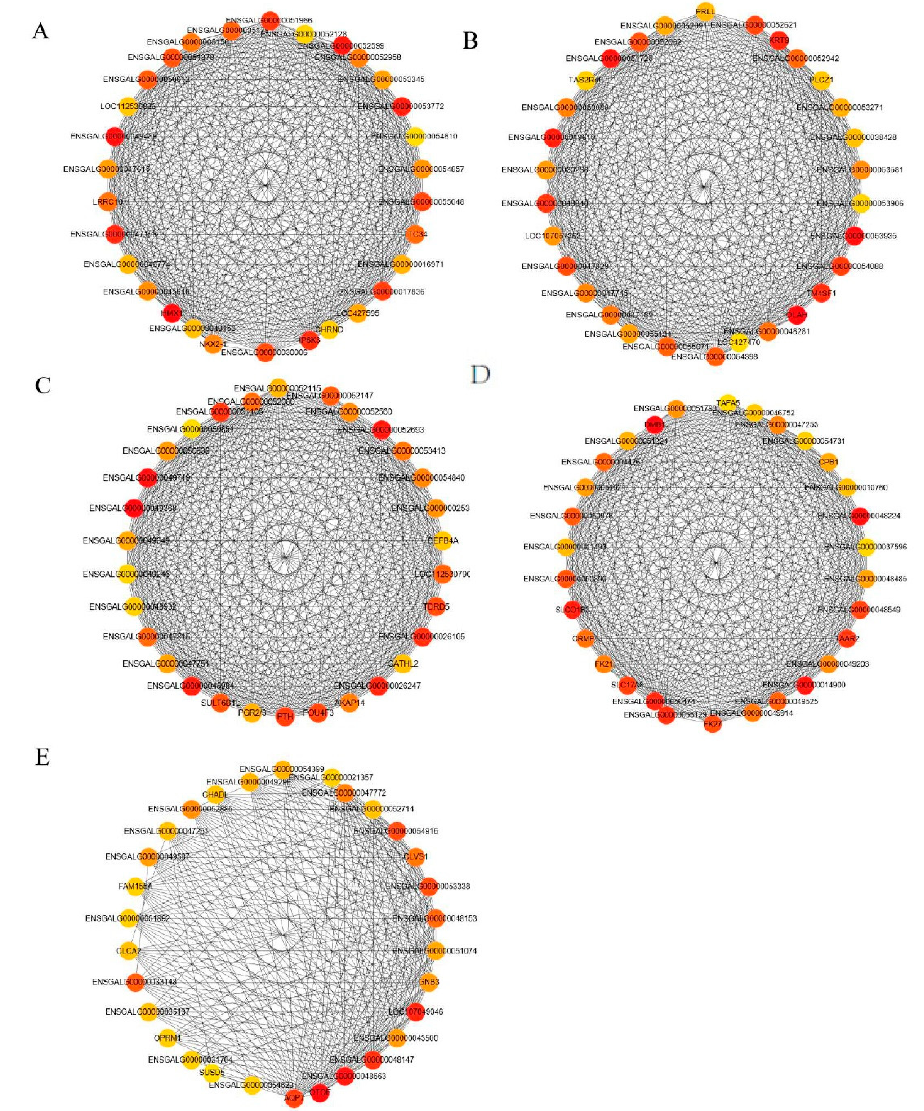
Figure 7. Gene interaction network diagram of the top 30 MCC value in the module. ( A ) cyan module, ( B ) brown module, ( C ) magenta module, ( D ) grey60 module, and ( E ) orange